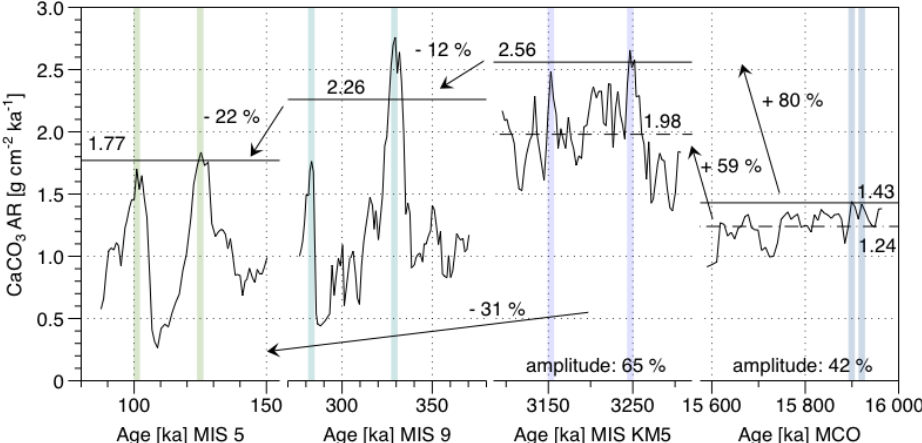
Figure 10. CaCO 3 AR for each period of interest, average value between two maxima per period (for Quaternary and Pliocene), average value taking into account maxima and minima for the Pliocene and the Miocene, and quantification of change within (amplitude) or between each of the periods of interest. The shaded areas are underlying the maxima values of CaCO 3 AR used for the quantification of change between the time intervals